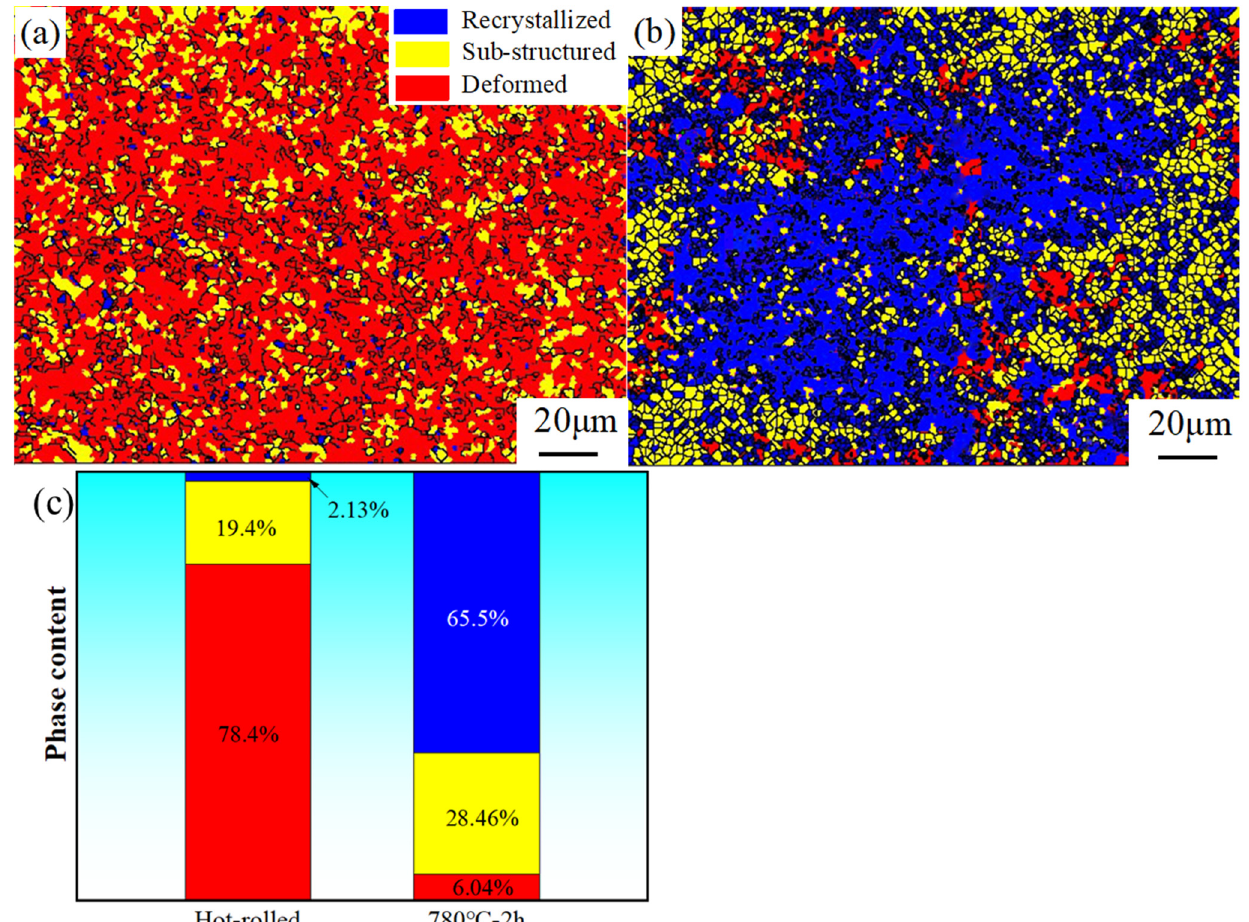
Figure 11. Recrystallization diagram of TA10 alloy: ( a ) hot-rolled, ( b ) 780 °C 2 h, ( c ) proportion of recrystallization, substructure, and deformation.